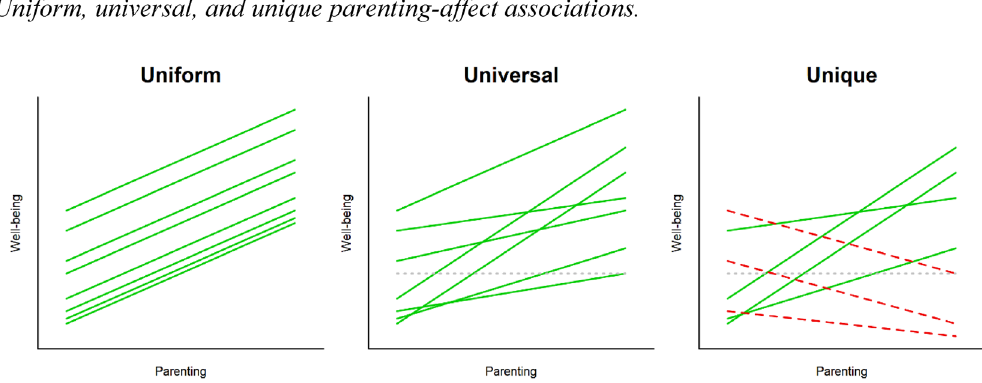
Figure 1. Note: Each line represents the association between parenting and well-being for one family. Green solid lines indicate a positive association, grey dotted lines indicate a null association, and red dashed lines indicate a negative